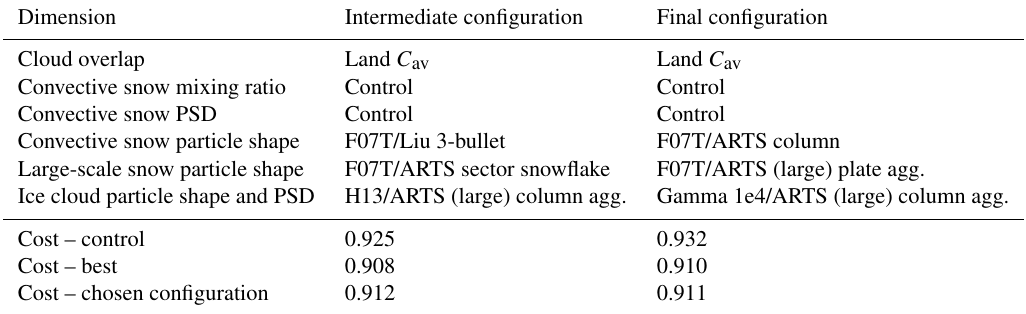
Table 7. RTTOV v13.0 development and final